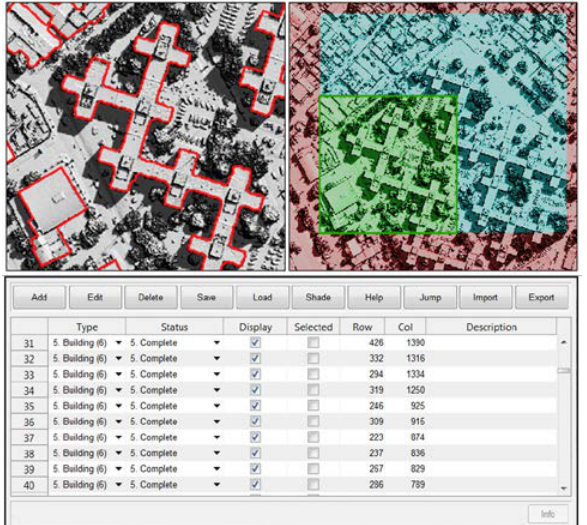
Figure 4 JHU/APL manual editing tool for building polygons includes a drawing window (top left), a context window (top right), and a polygon attribute table